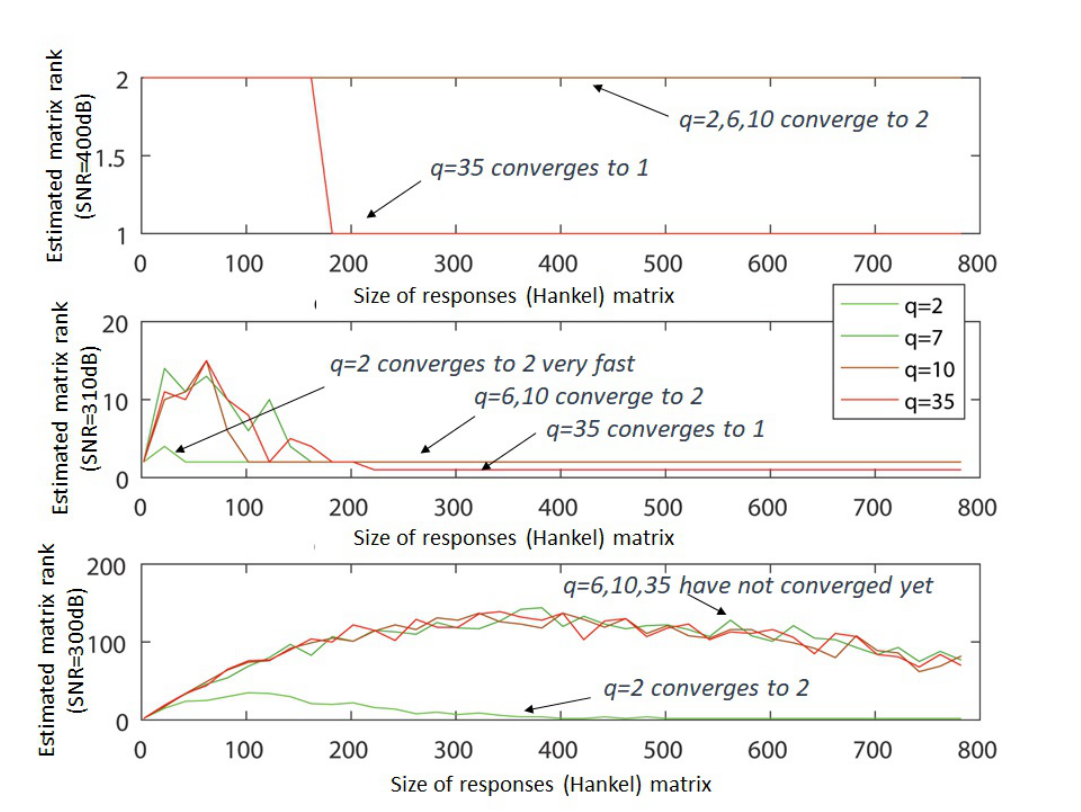
Figure 5. The rank of the responses matrices as a function of the responses matrix dimensions and the proximity of the poles in the case of a second order system. Noise is